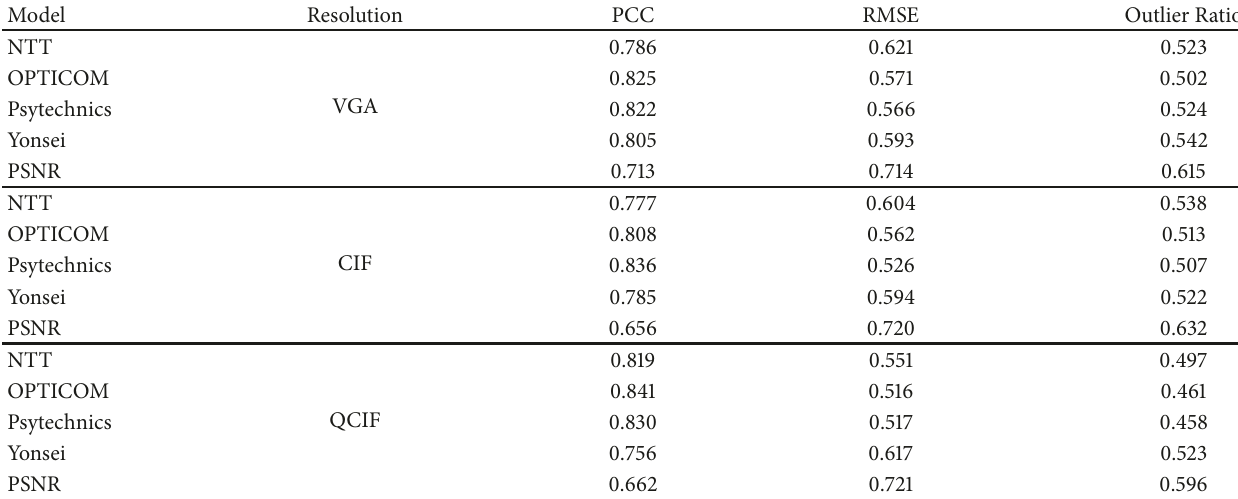
Table 12: Model performance overview.